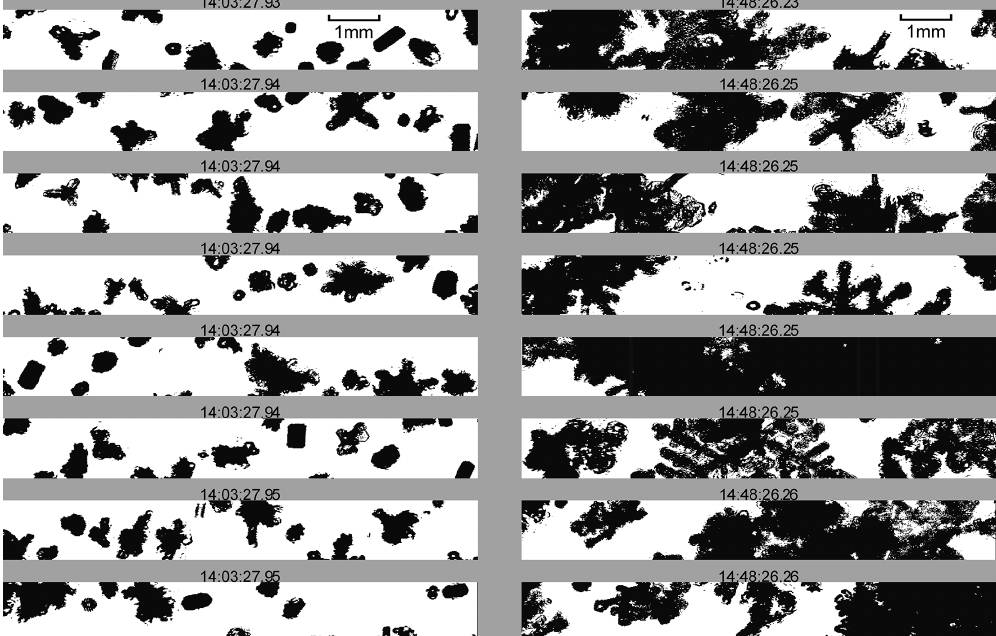
Figure 3. Examples of particle 2D-S images (same scale) with D v ≈ 1.4mm and DWR ≈ 1.8dB (left) as well as D v ≈ 8mm and DWR ≈ 16dB (right). DWR data are for the horizontal radar beam measurements.